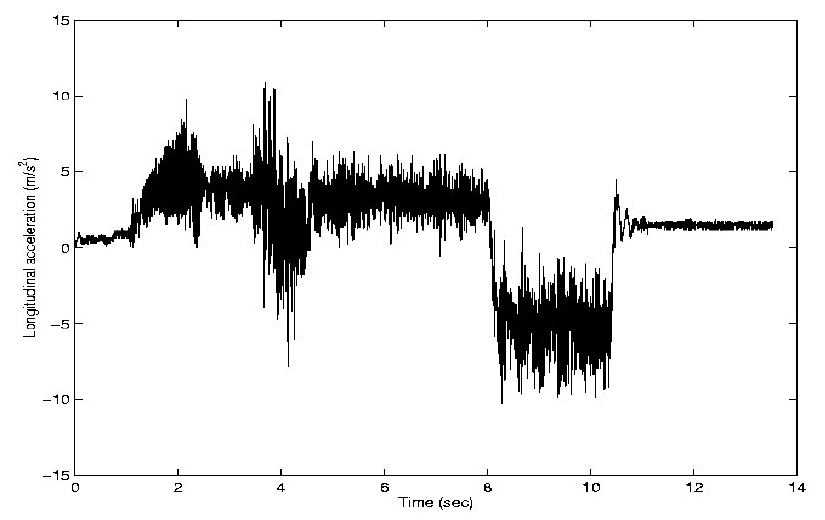
Figure 7. Longitudinal acceleration (m/s 2 ) vs. Time (sec).